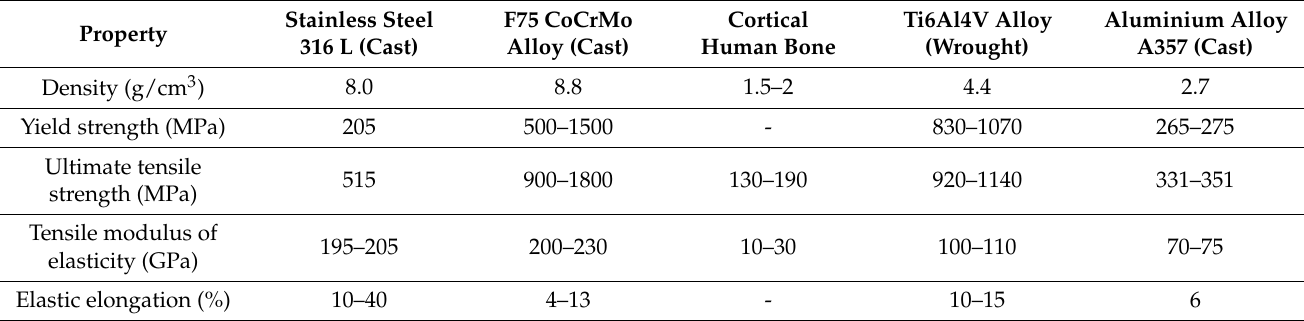
Table 1. Some physicomechanical properties of Ti6Al4V alloy, 316 L stainless steel, CoCrMo alloys, cortical bone, and A357 aluminum alloy